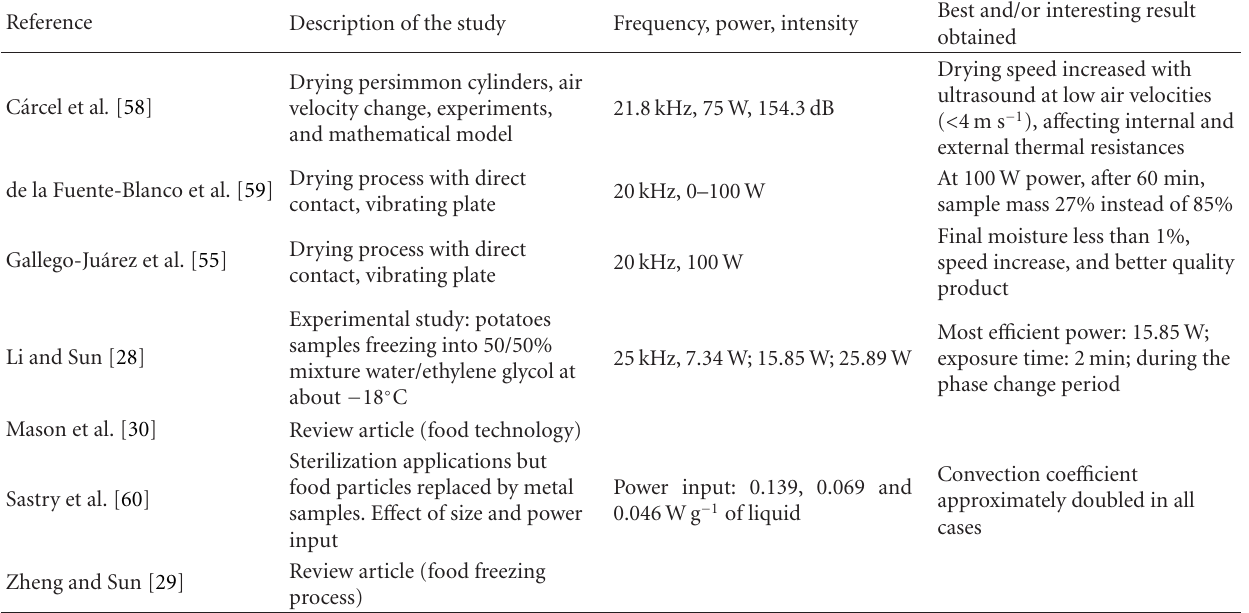
Table 3: Reported uses of ultrasound in food